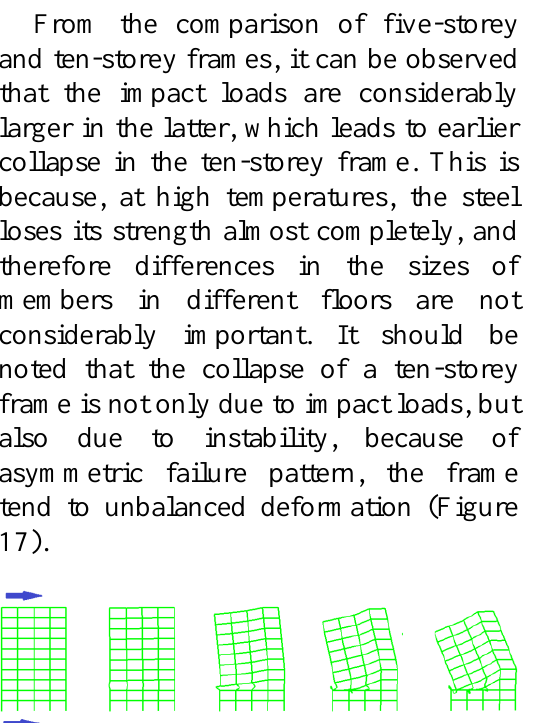
Fig. 14. Time-history of kinetic energy in 10-storey frame.